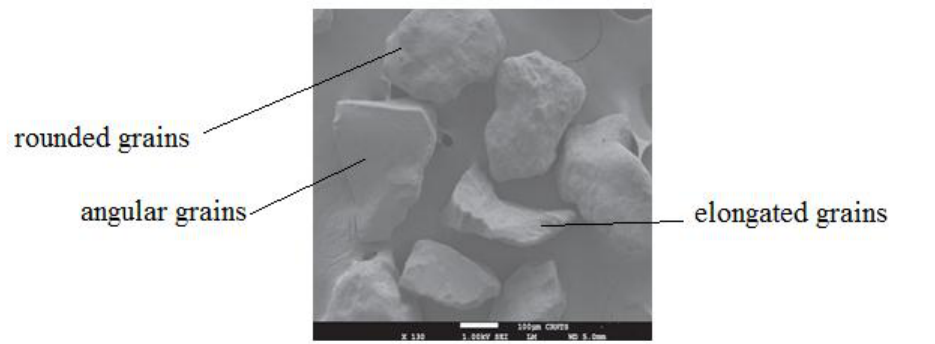
Figure 4: Scanning electron Micrograph of Biskra Dune Sand (lower magnitude).